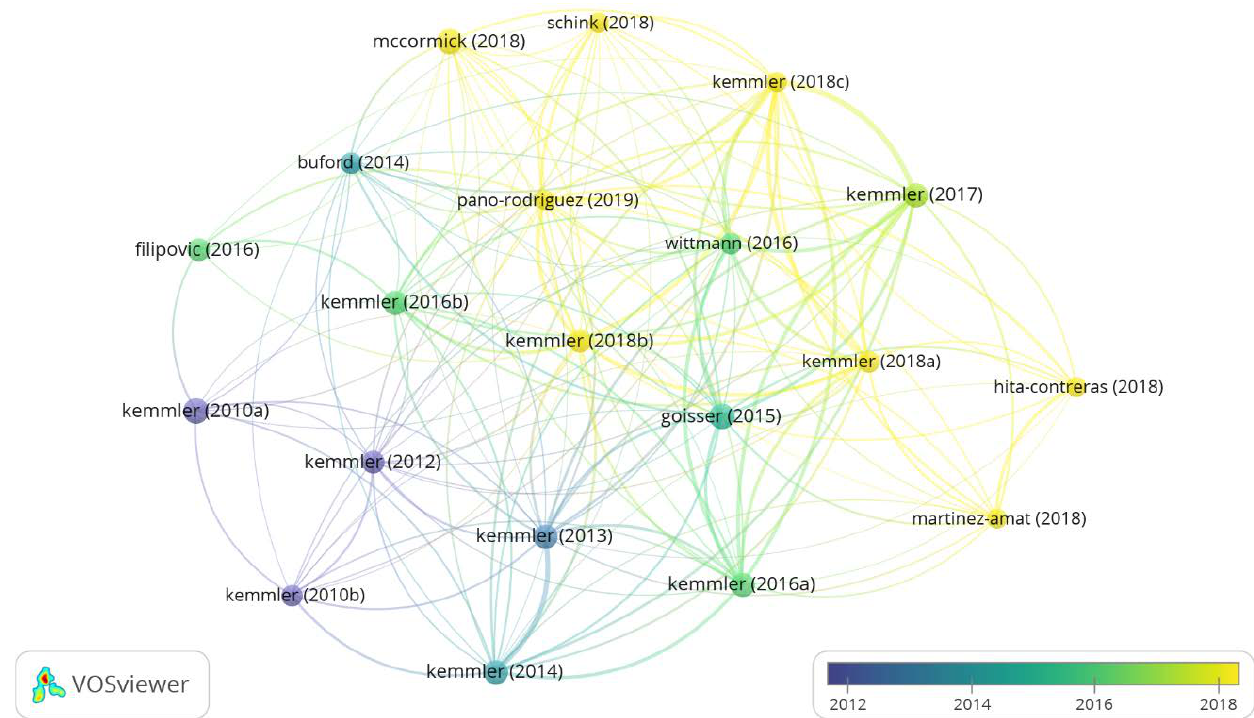
Figure 6. Graph with most relevant articles, according to h-index.